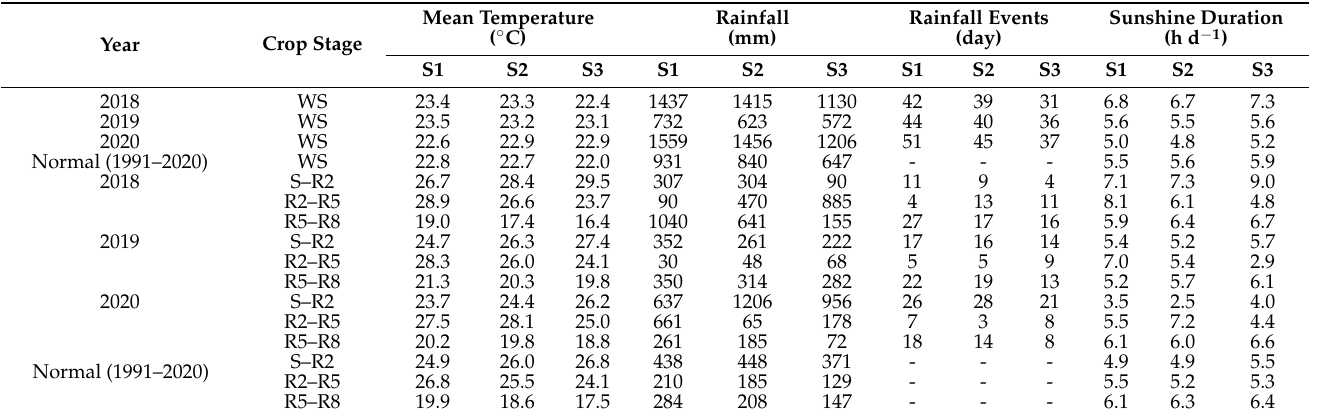
Table 2. Weather conditions during the whole season and each growth period with different sowing dates of double-crop soybeans grown in drained paddy fields over three years (2018–2019) and normal year